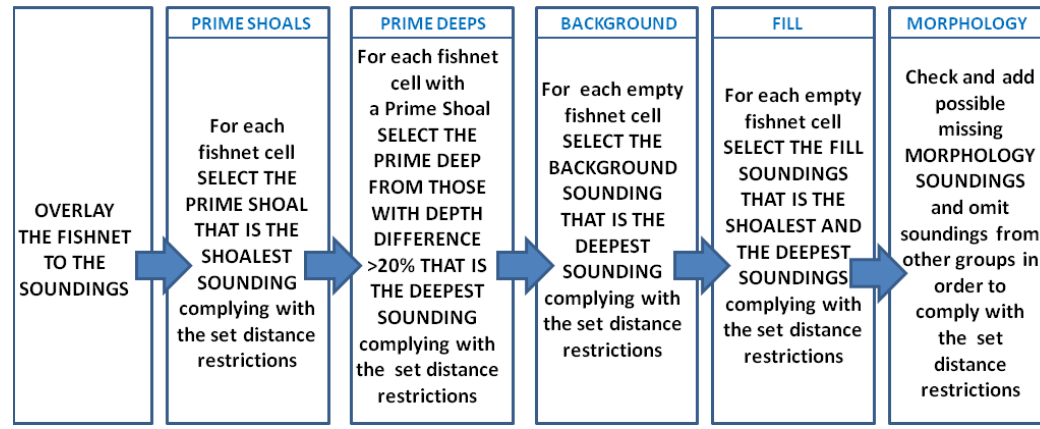
Figure 7. Morphology related soundings: sounding 0.5 m results to the deletion of soundings 0.1 m and 2.3 m (in blue) due to short distances between them.